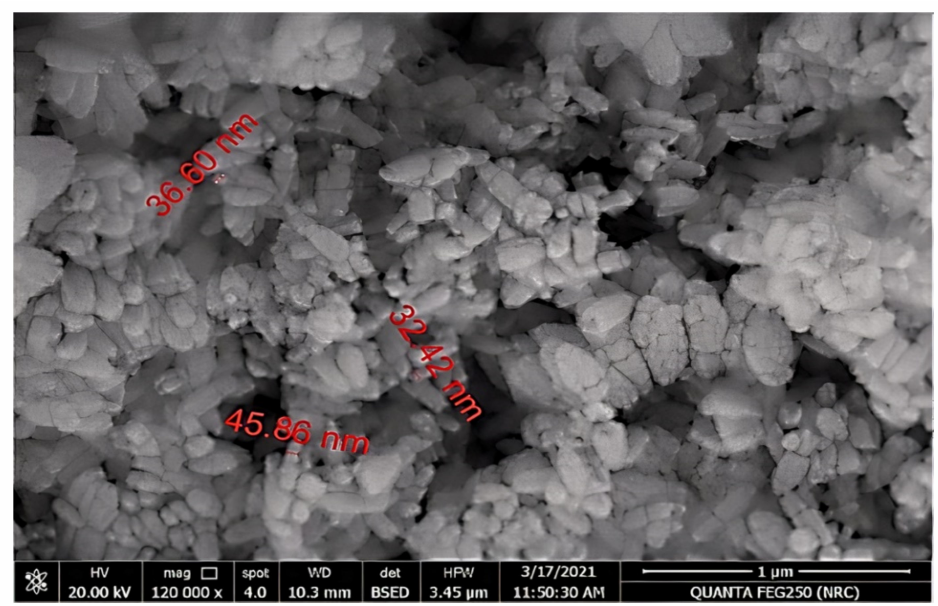
Figure 9. SEM analysis of ZnO